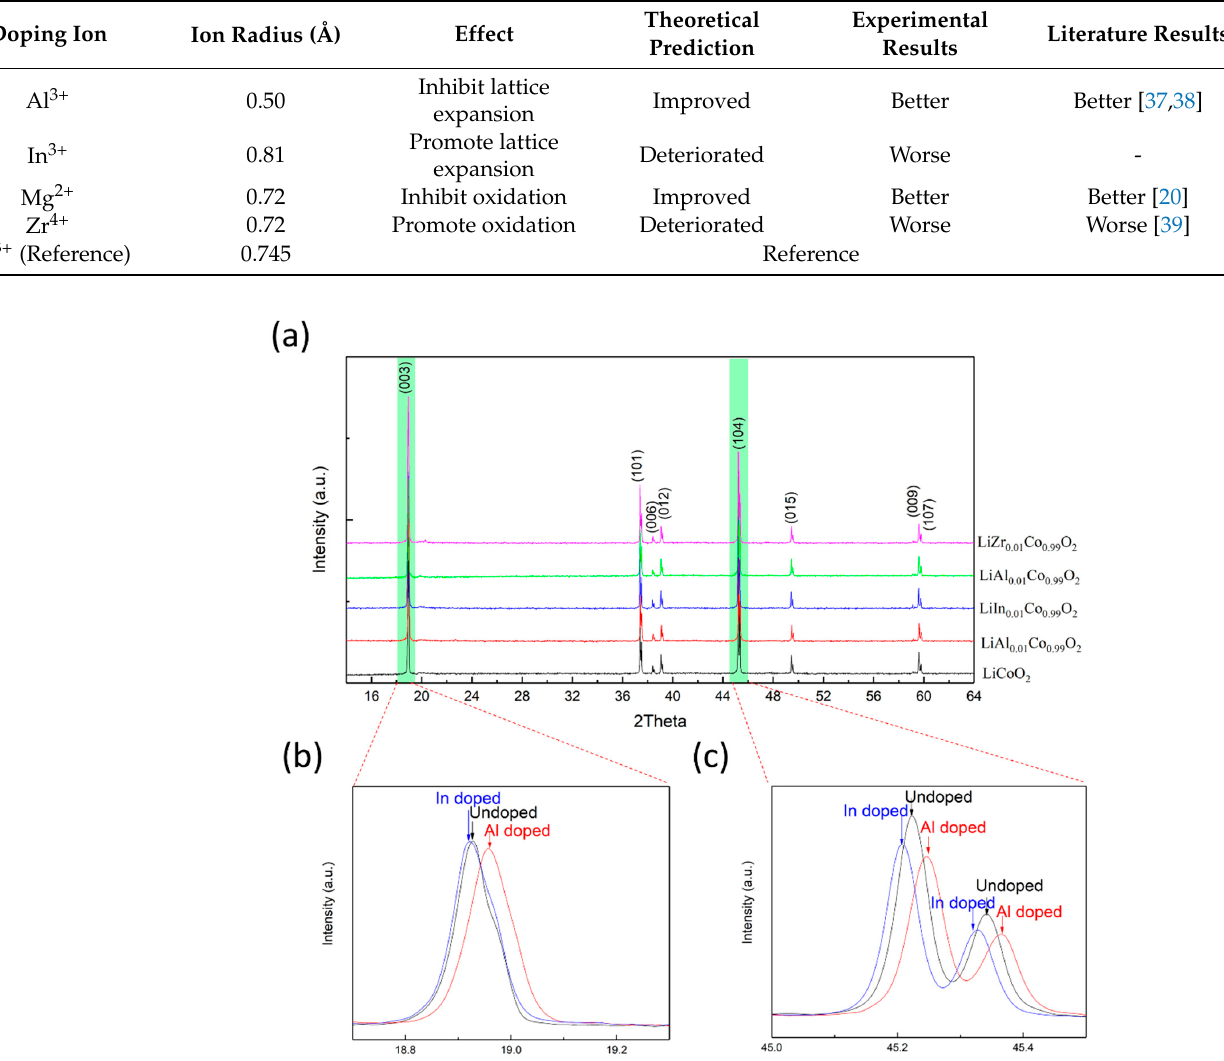
- Figure 7 shows the cycling performance and charge-discharge profiles of doped and undoped LiCoO 2 samples. The galvanostatic charge-discharge performance was meas- ured at 0.5 C by charging to 4.3 V. After 100 cycles, Al and Mg doped LiCoO 2 exhibited